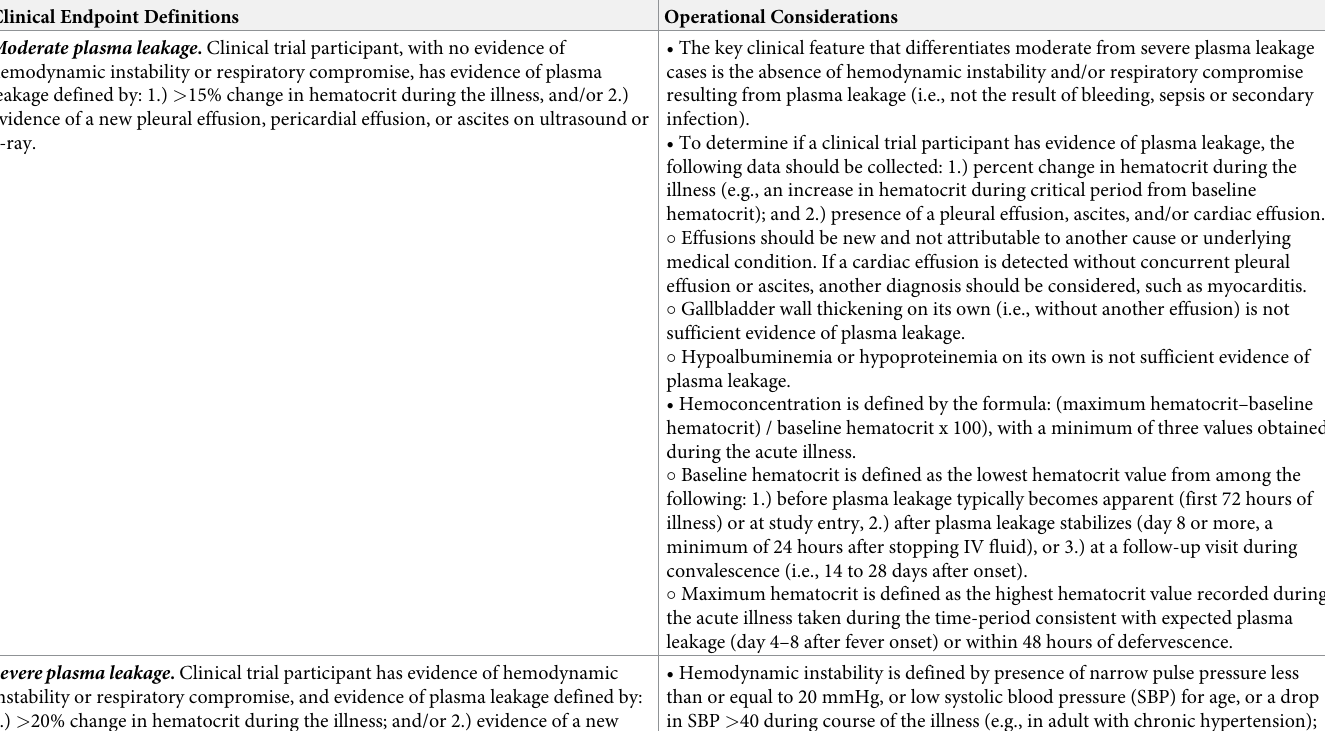
Table 2. Summary of final clinical endpoint definitions and operational considerations. Clinical Endpoint